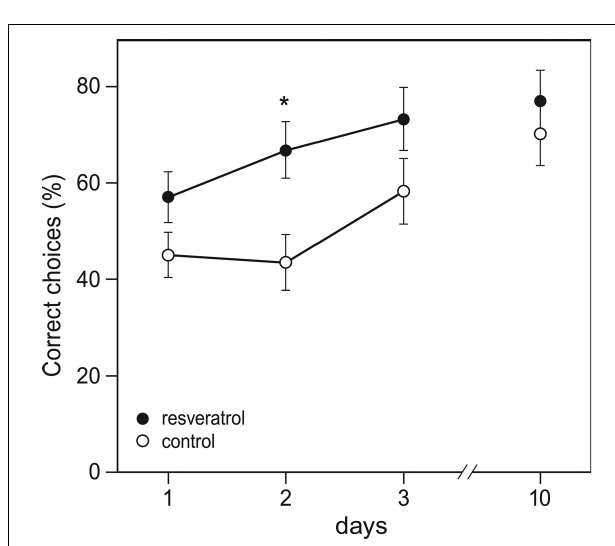
FIGURE 1 | Effects of chronic resveratrol supplementation on locomotor behavior in an open fi eld. The test duration was 5 min and locomotion of CON ( n = 28) and RES ( n = 28) animals was monitored with an automated video analysis system. (A) Total distance covered during the test. (B) Time spent in the center area (diameter: 60 cm) of the arena (* p =0.003).